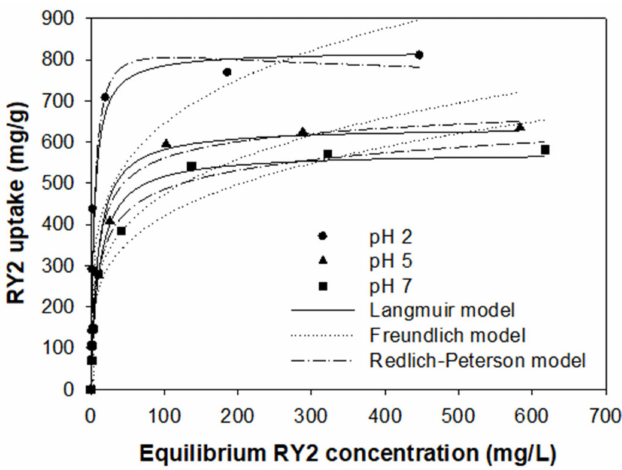
Figure 6. Adsorption isotherms of RY2 on the PEI/PVC-CF at different pH values (experimental conditions: m = 0.02 g, V = 30 mL, C i range = 100–1000 mg/L, and temperature = 25 ◦